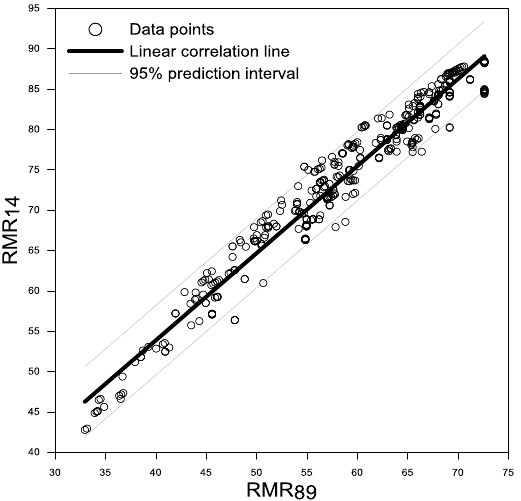
Figure 4. Correlation between the two versions of RMR [58].